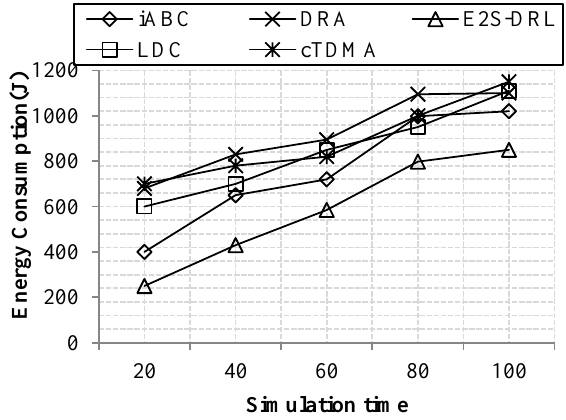
Figure 7. Comparison of energy consumption vs. simulation time.